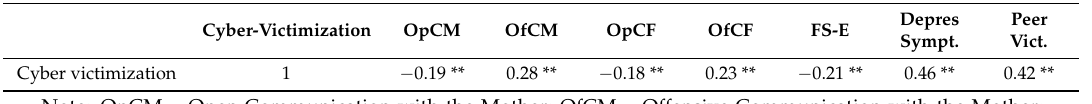
Table 5. Correlations among cyber-victimization, family communication, family self-esteem, depressive symptomatology, and peer victimization. OpCM